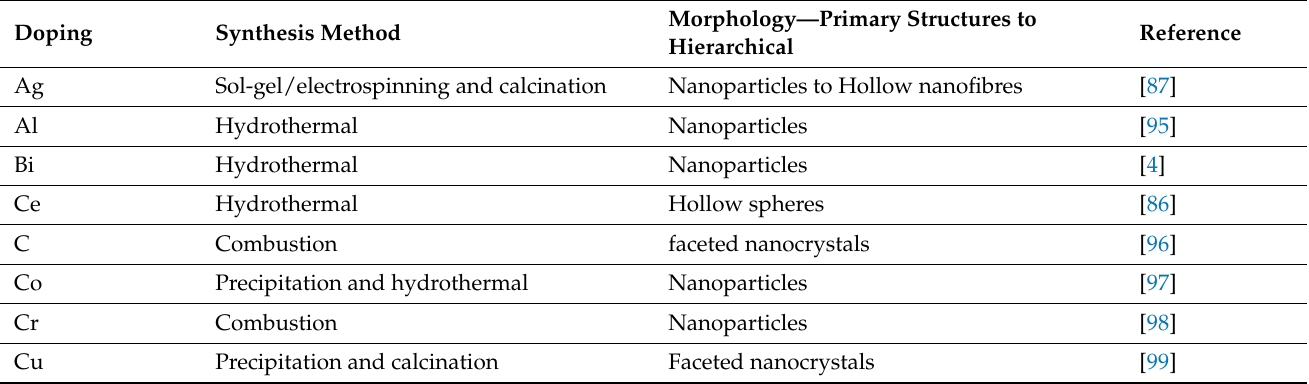
Table 1. Some references for doped SnO 2 , their synthesis approach and morphological